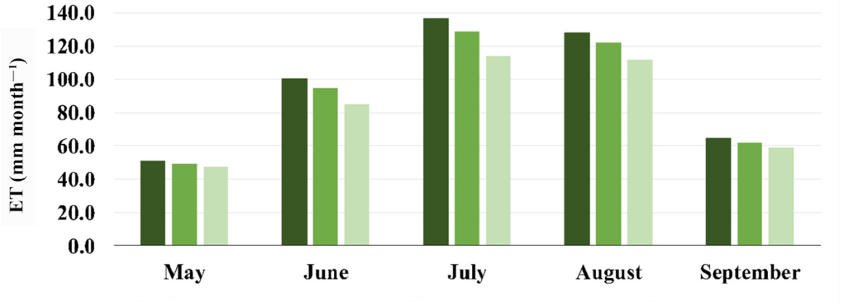
Figure 8. Simulated monthly ET rates of different cover types under scenario 2 (middle stomatal conductance for all crops).